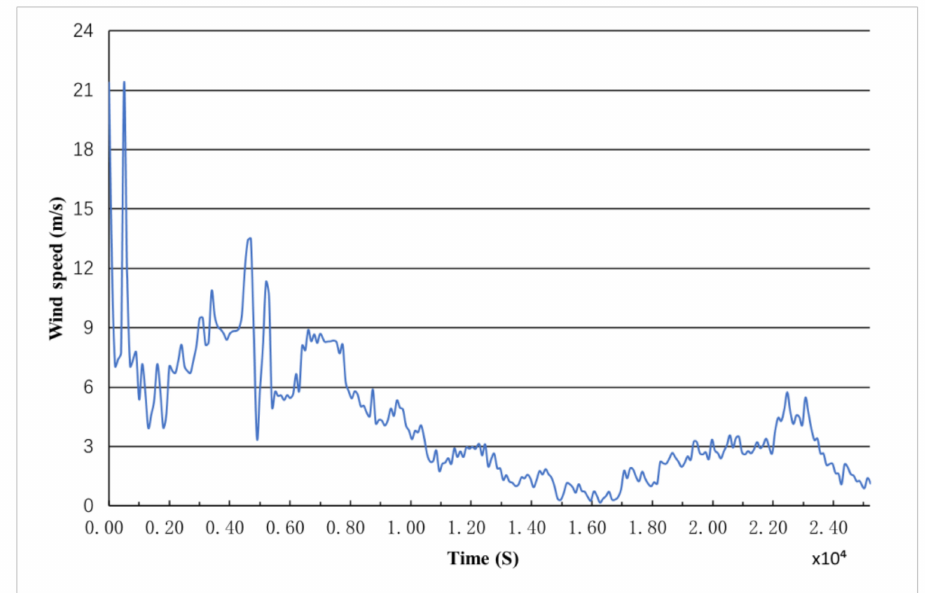
Figure 5. Measured airship flight velocity during a flight